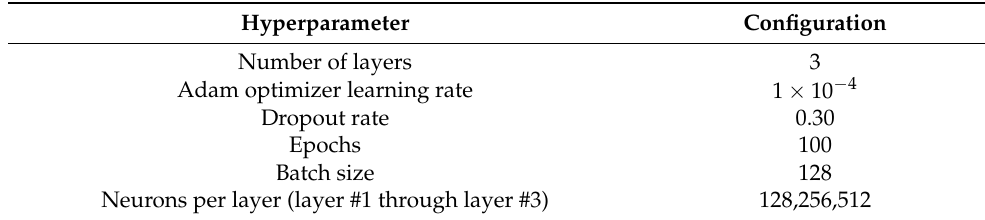
Table 4. Hyperparameter settings for the proposed